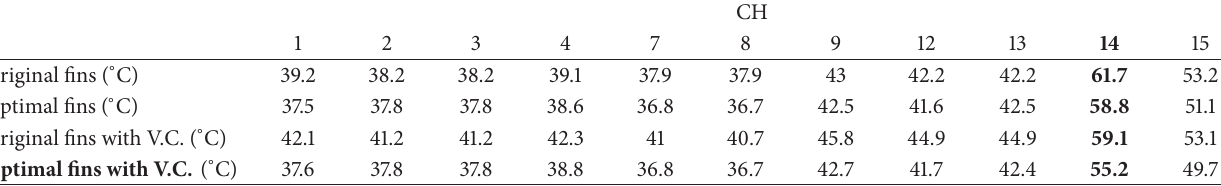
Table 7: Comparisons between original design and modified